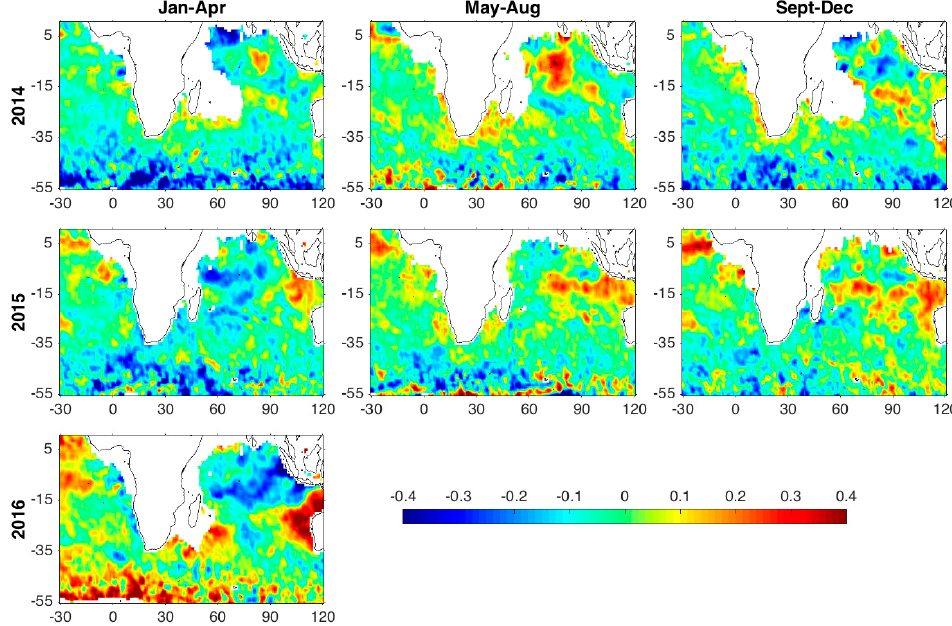
Figure 12. Composite mean of Soil Moisture Ocean Salinity (SMOS) SSS anomalies from January–April ( first column ), May–August ( middle column ) and September–December ( last column ) during the most recent El Niño event starting and stopping in 2014 ( top row ), restarting in 2015 ( middle row ), and reaching its peak in 2016 ( bottom row ).